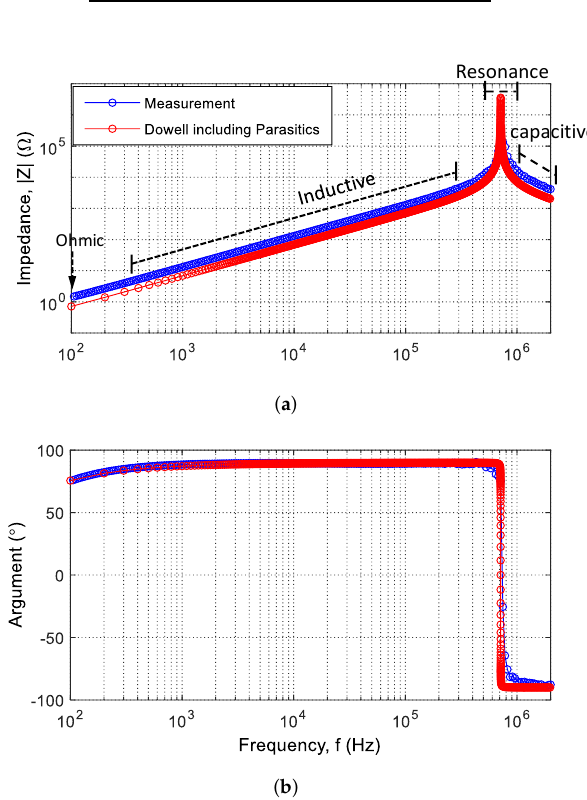
Figure 11. Total winding impedance as a function of frequency. ( a ) Magnitude, and ( b ) argument of modeled impedance compared to experimental